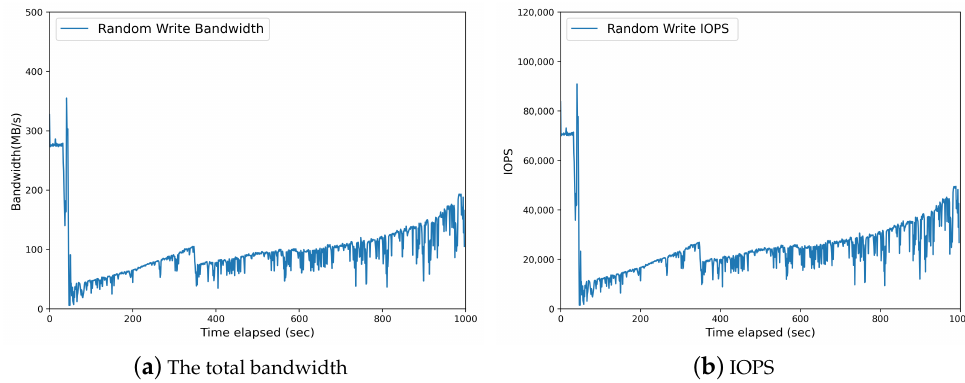
Figure 6. The total bandwidth and IOPS for random write operations on a fully occupied